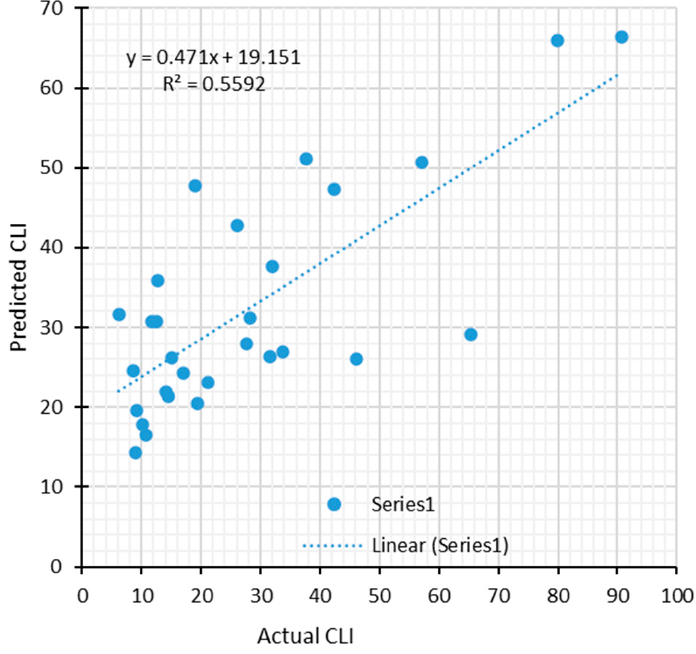
Figure 11. Relations between the measured CLI and predicted CLI for testing (model 1-MLRM). Table 8. Summary of non-linear multi-variable statistical analysis of CLI.